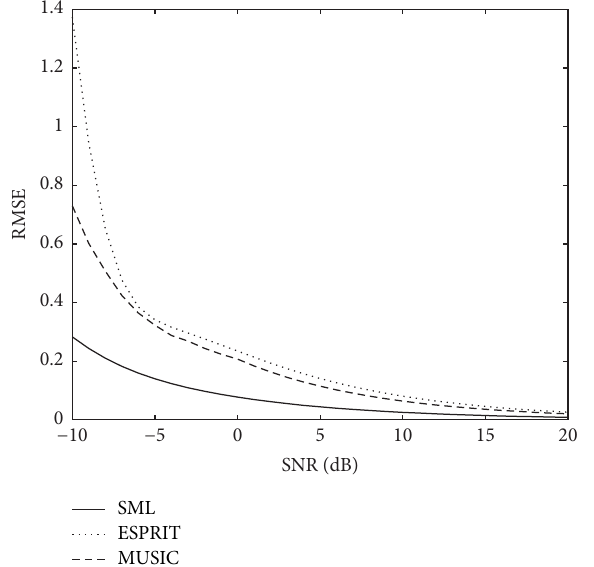
Figure 3: Comparison of RMSE between SML, MUSIC, and ES- PRIT.